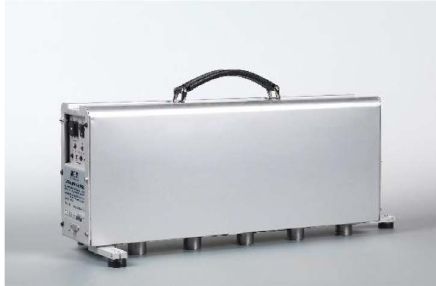
Figure 2. Reference tapping machine (RTM).